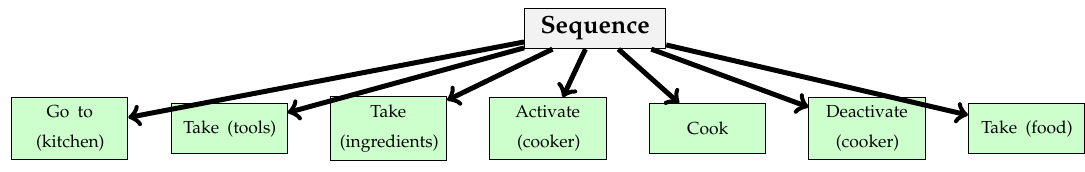
Figure 6. Behavior trees that manage a cooking scenario. In this Figure, the names between the parenthesis represent parameters. The node “cook” plays cooking animation.